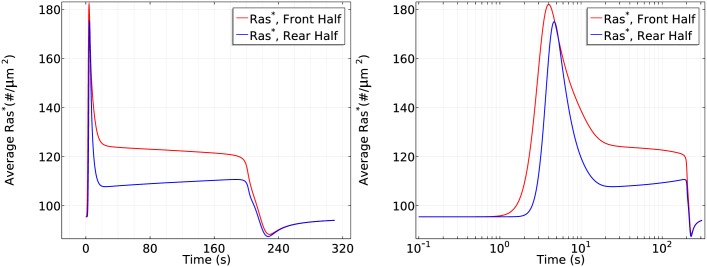
The time course of average Ras* activity in a triangle wave at normal wave speed v = 5μm/s.